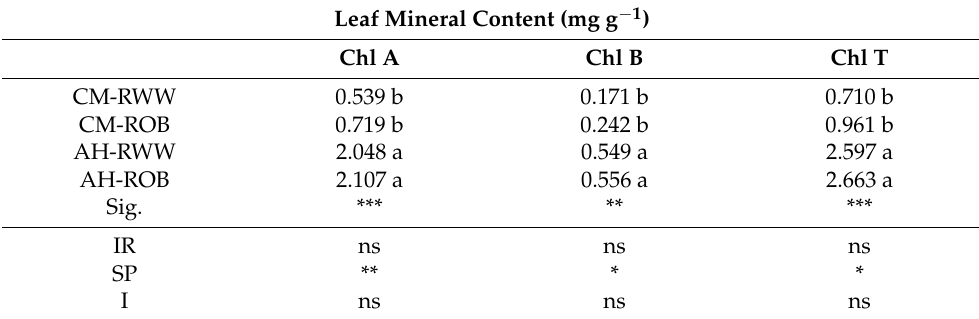
Different lowercase letters indicate significant differences between treatments according to Duncan’s test at p ≤ 0.05. * p < 0.05, ** p < 0.01 and *** p < 0.001. p > 0.05 non-significant differences are indicated by